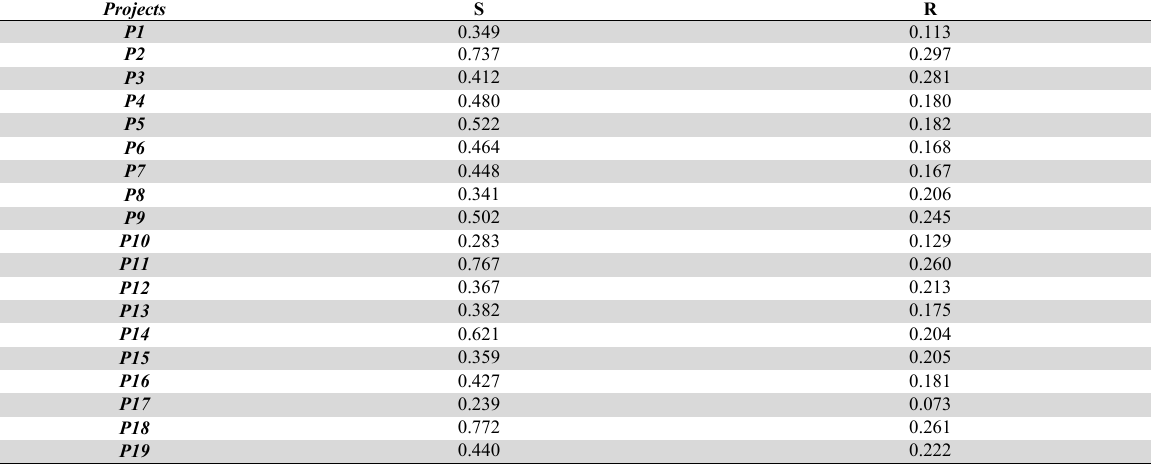
Values of each utility and satisfaction indicator for each alternative